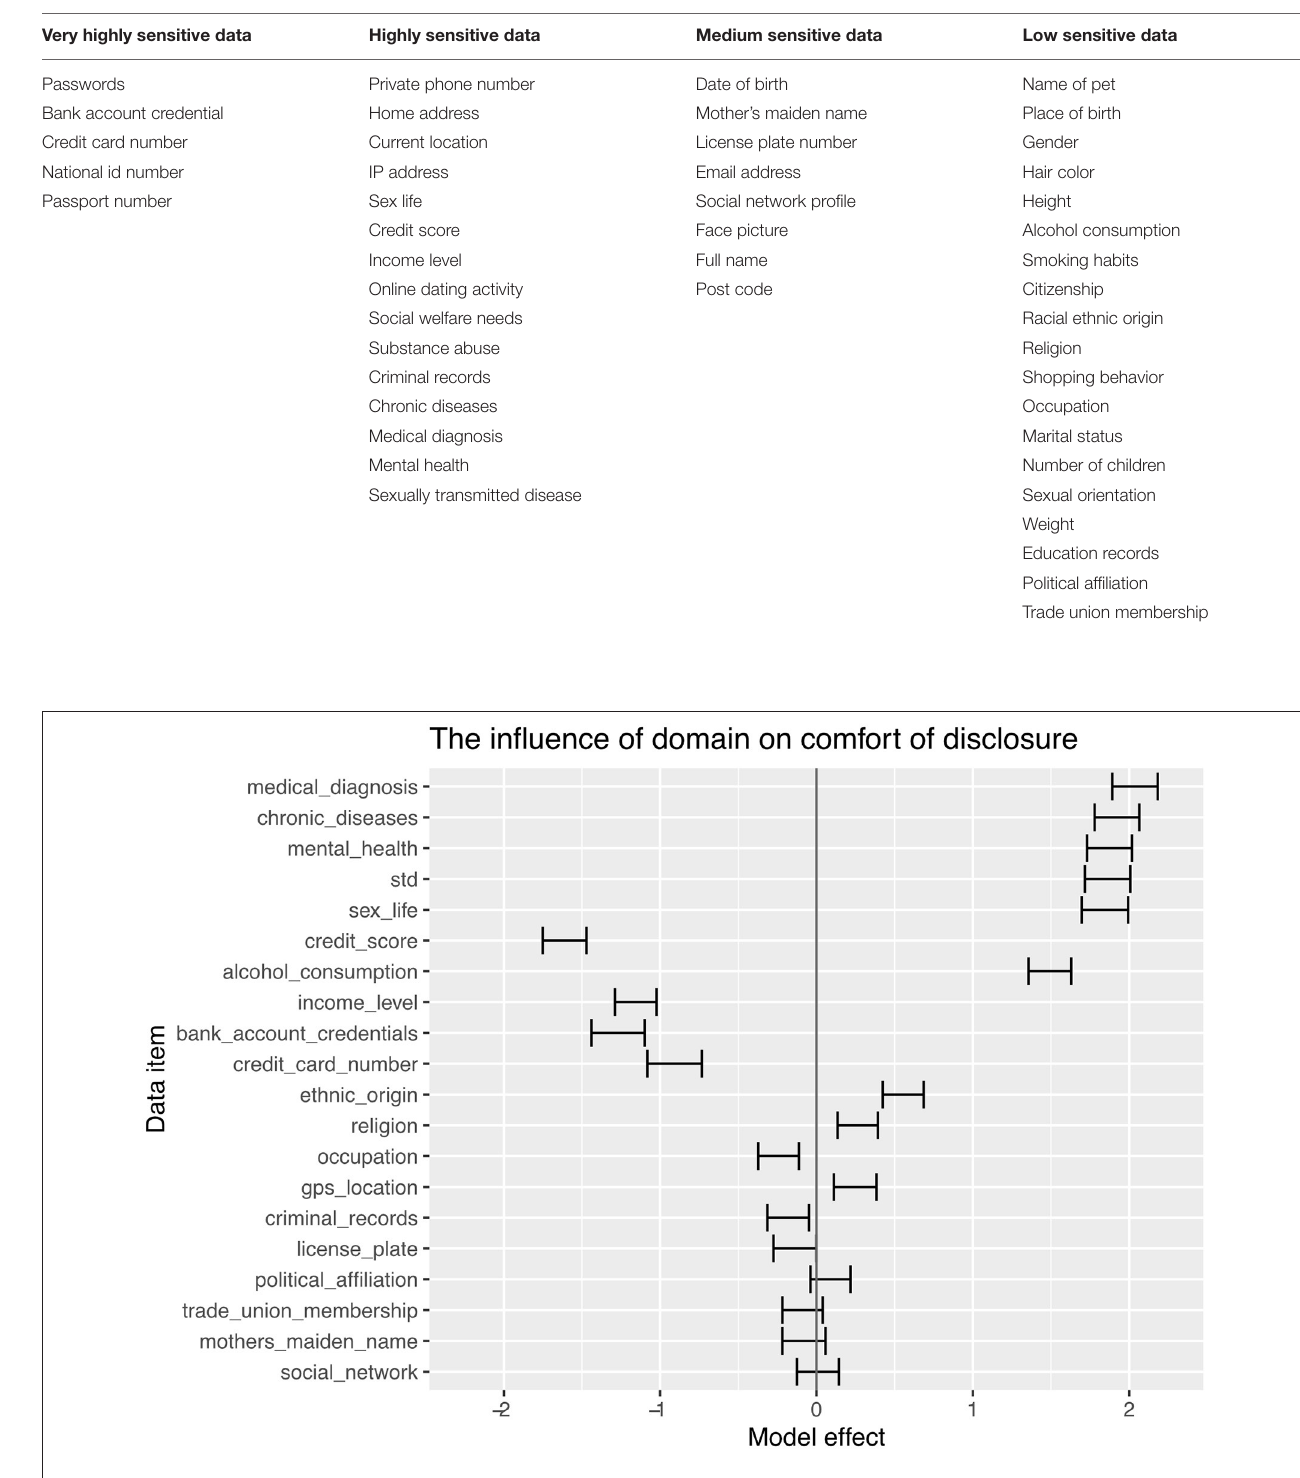
TABLE 6 | Clusters of data items based on sensitivity.